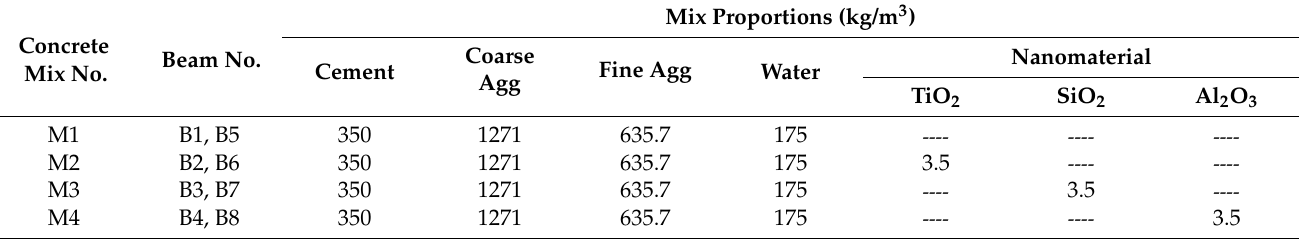
Table 2. Mix proportions and beams numbers. Concrete Mix No.